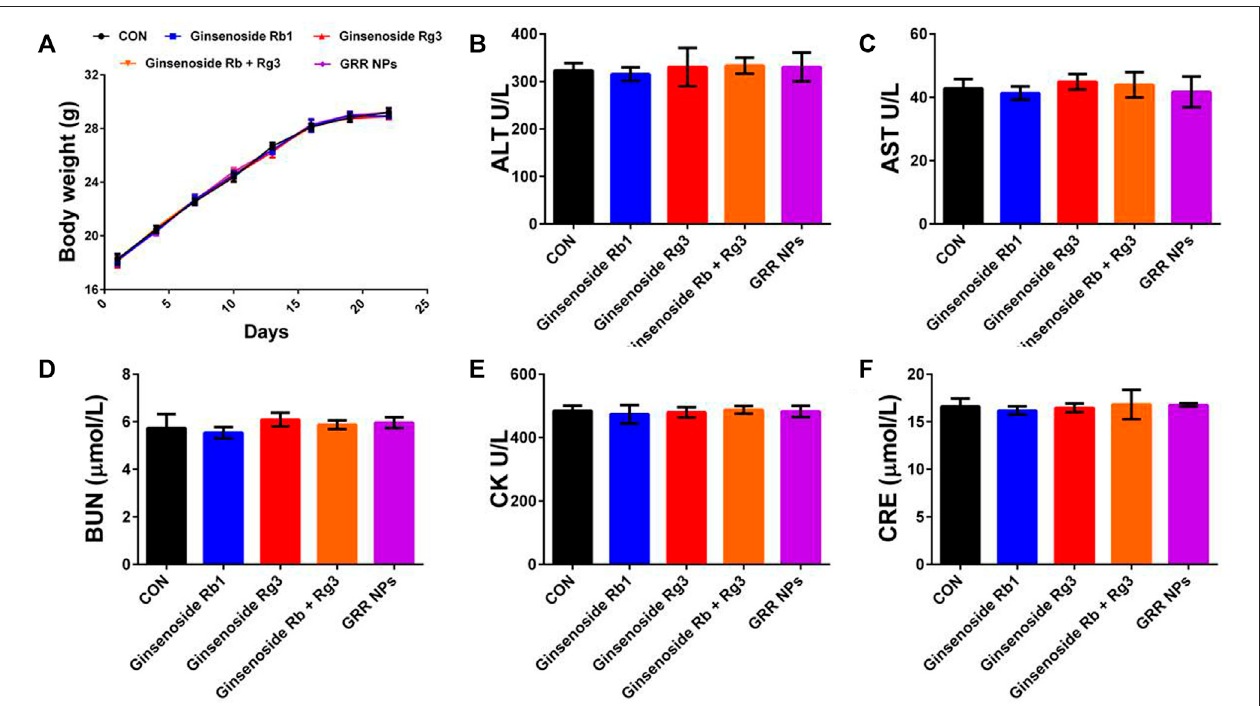
FIGURE 5 | Biosafety effect of Rg3-Rb1 NPs. (A) Body weight, (B) ALT, (C) AST, (D) BUN, (E) CK, and (F) CRE of 4T1 orthotopic mammary mouse. ALT, alanine aminotransferase; AST, aspartate aminotransferase; BUN, blood urea nitrogen; CRE, serum creatinine; NPs, nanoparticles.